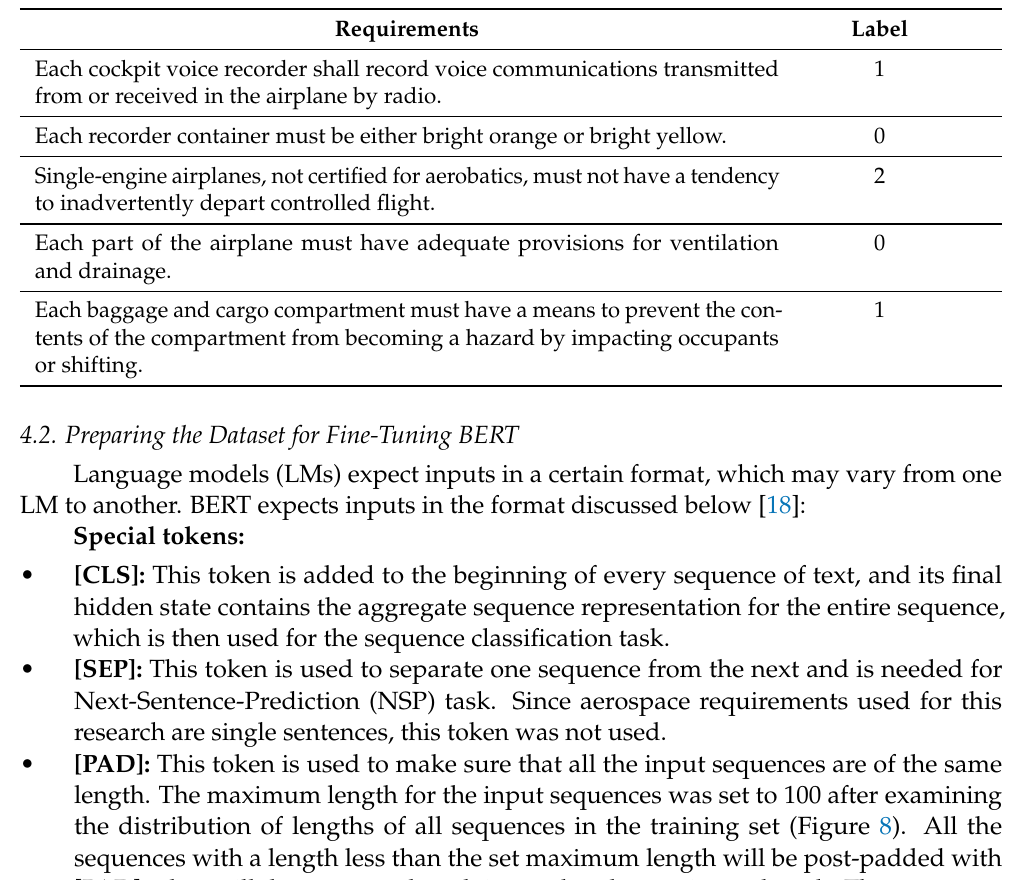
Table 7. Classification dataset format.